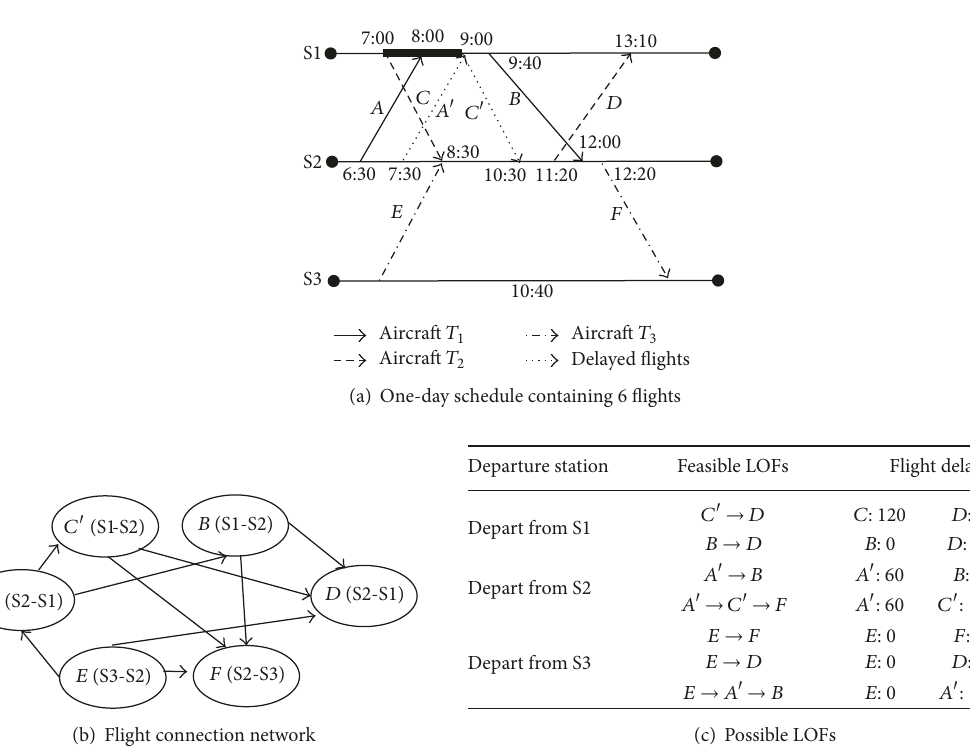
Figure 3: LOF generation with airport disruptions: (a) one-day schedule of three aircraft with six flights and one airport closure; (b) flight connection network; and (c) feasible